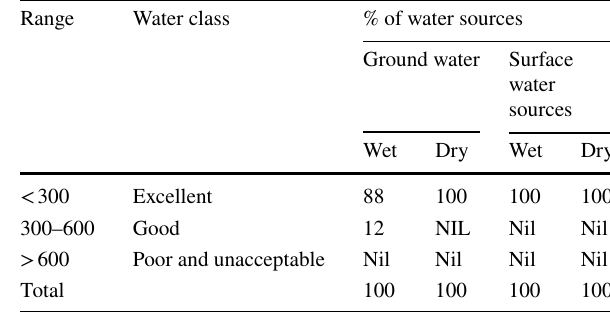
Table 3 Classification of water sources based on pH Range